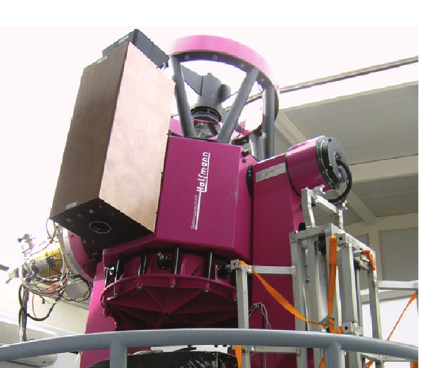
Figure 2: Photo of a TORTORA camera, mounted on top of REM robotic telescope in La-Silla Observatory, ESO,